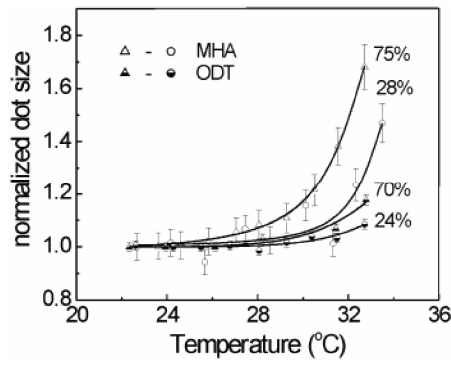
Figure 22. The effect of temperature on the droplet size for hydrophilic (MHA) and hydrophobic (ODT) molecules on a DPN at different % of RH levels is shown. Reprinted with permission from